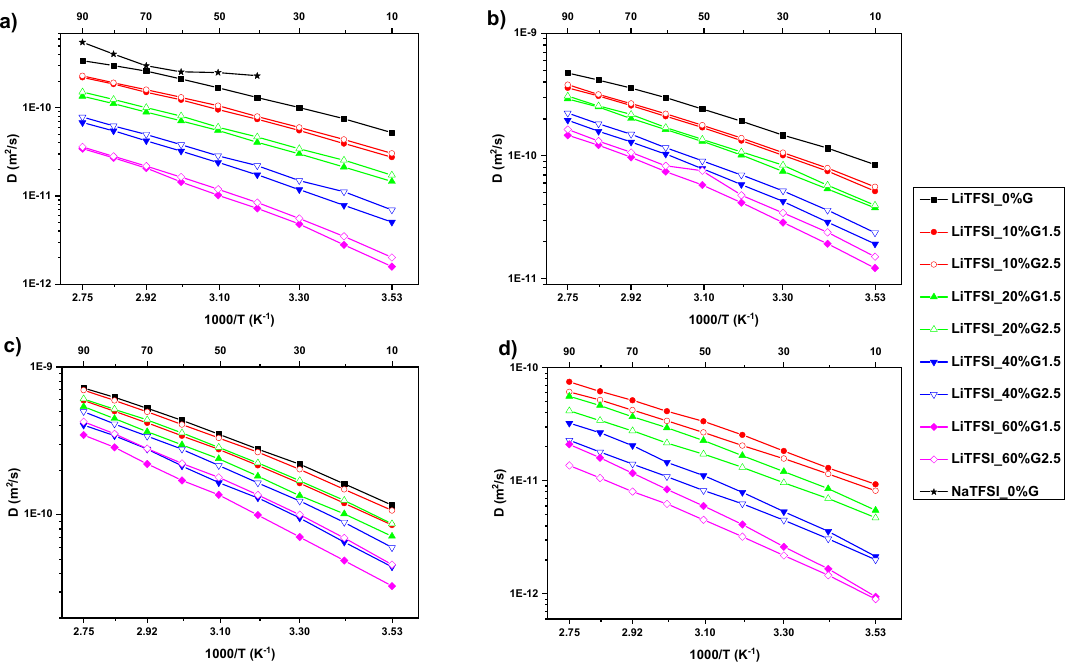
Figure 5. Temperature dependence of NMR self ‐ diffusion coefficients for the LiTFSI ‐ based electrolytes for Li cation ( a ), TFSI anion ( b ), PC molecules ( c ), and PAMAM molecules ( d ). The solid lines are guides for the eye.